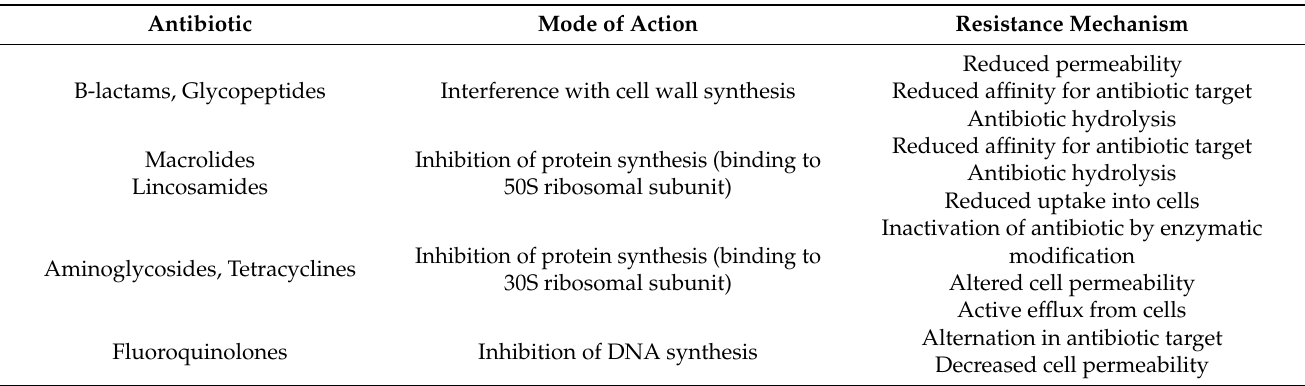
Reduced permeability Reduced affinity for antibiotic target Antibiotic hydrolysis Reduced affinity for antibiotic target Antibiotic hydrolysis Reduced uptake into cells Inactivation of antibiotic by enzymatic modification Altered cell permeability Active efflux from cells Alternation in antibiotic target Decreased cell